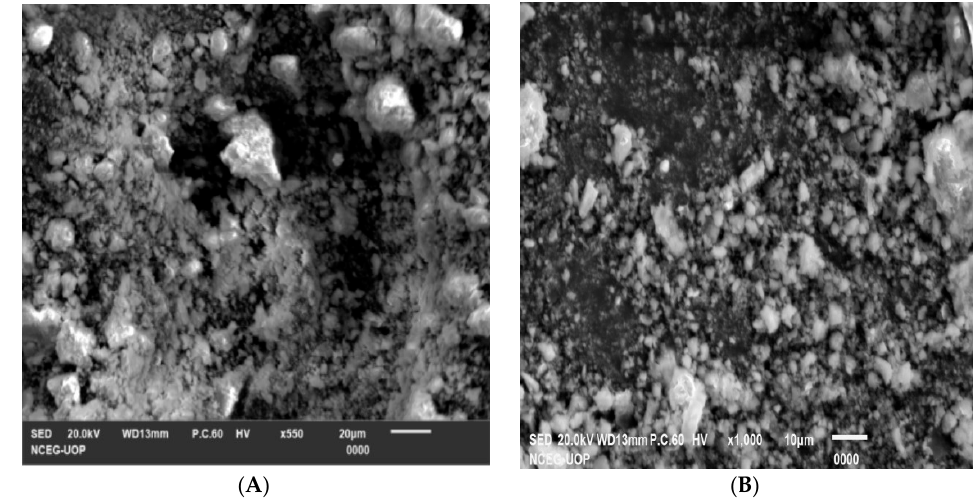
Figure 3. ( A , B ) SEM micrographs of the synthesized Co-CeO 2 /C Figure 3. ( A,B ) SEM micrographs of the synthesized Co-CeO 2 /C nanocomposite.